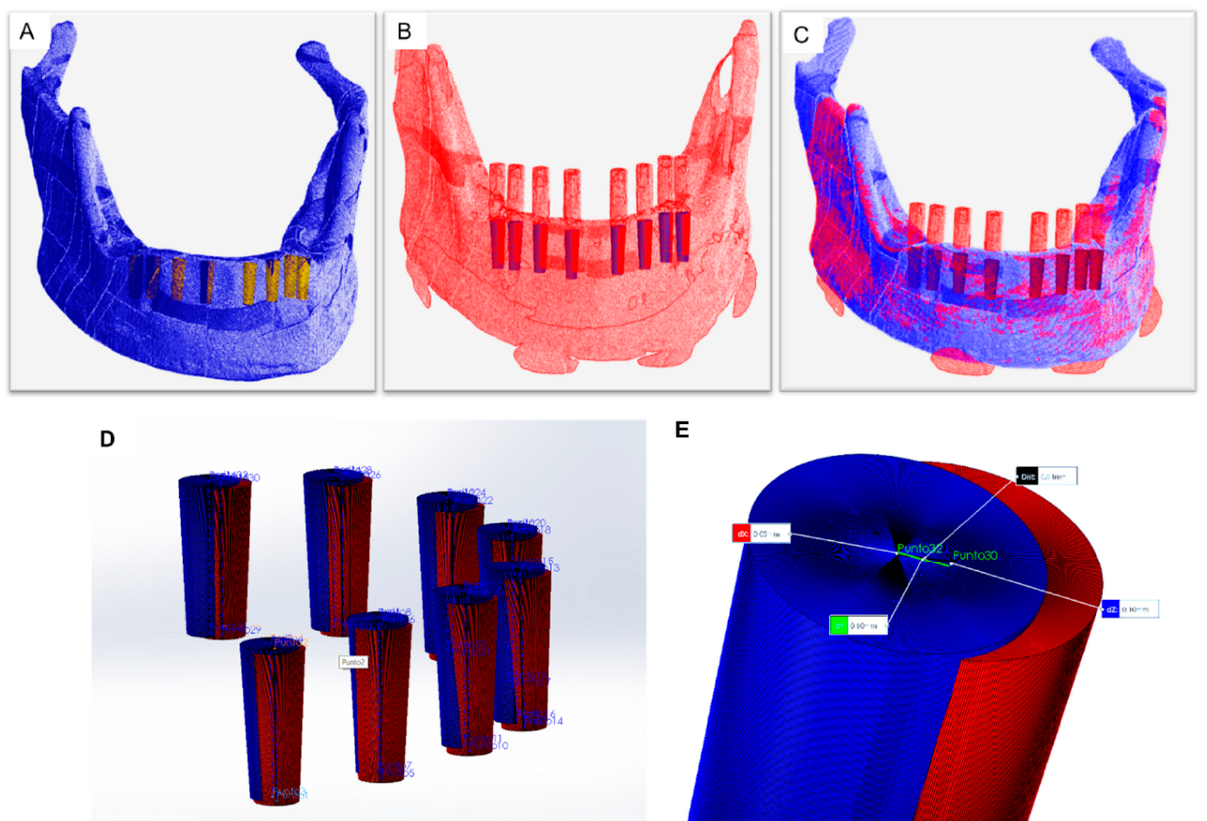
Figure 3. Pre- ( A ) and post- ( B ) operative virtual models and their alignment superimposing the external surfaces ( C ). Planned ( D ) and actual ( E ) implant positions after removing the models’ superimposing surface.